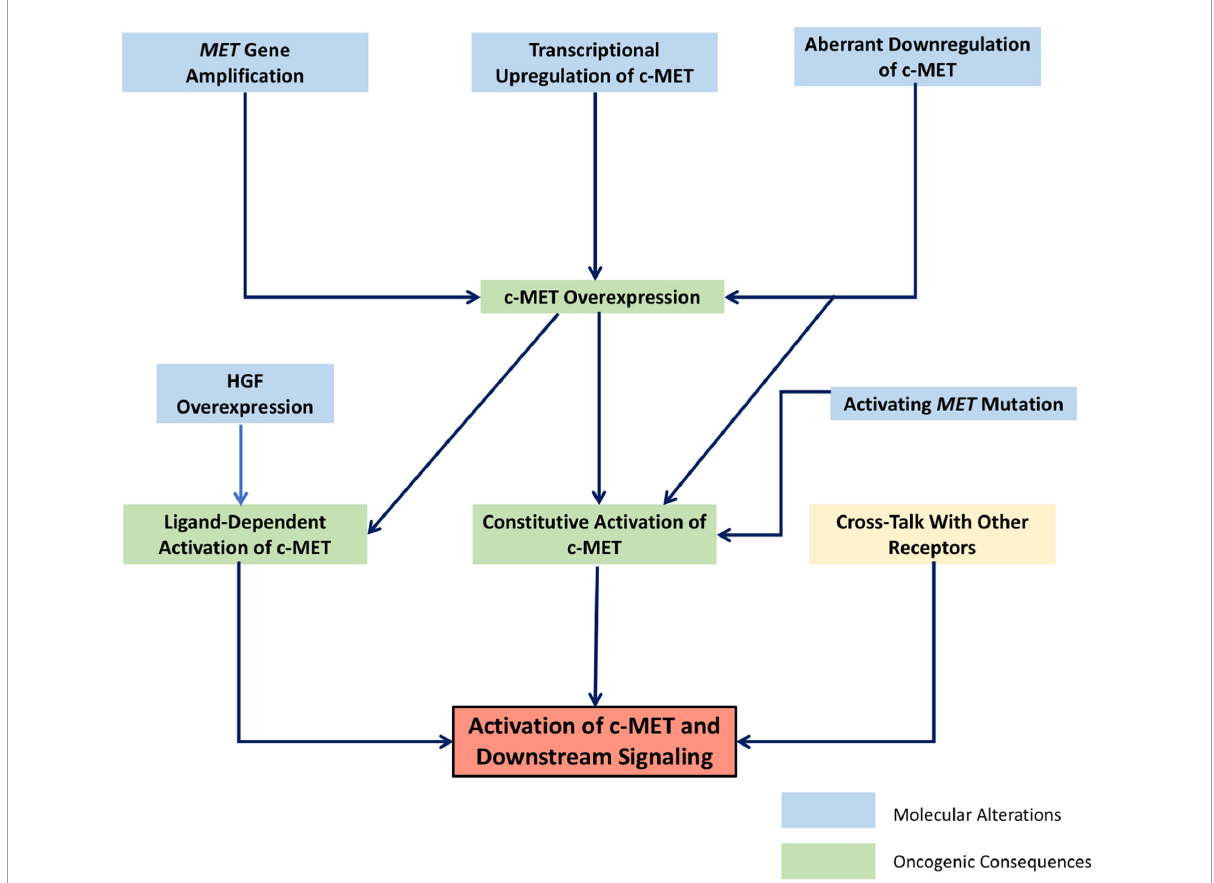
FIGURE1 Schematic representation of the molecular mechanisms leading to dysregulated signaling of the HGF/c-MET pathway. Interrelated molecular factors lead to changes in HGF/c-MET expression and activity, resulting in the activation of downstream signaling pathways which promote oncogenic cellular